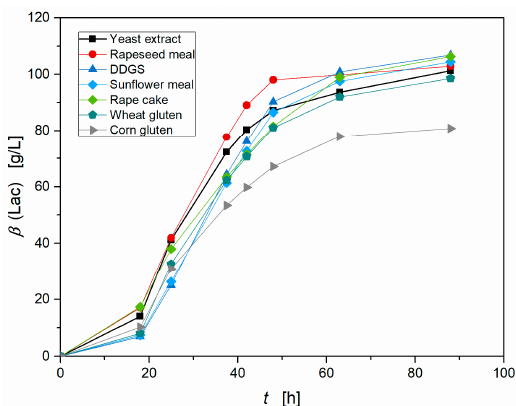
Figure 4. Comparison of the lactic acid production by S. inulinus with hydrolysates obtained by chemical hydrolysis with 3M H 2 SO 4 of distinct agricultural residues and applied as nutrient sources in GY-medium compared to the reference with yeast extract, incubated at 38 °C, 0 rpm. This versatility and flexibility cannot be achieved with enzymatic hydrolysis methods.